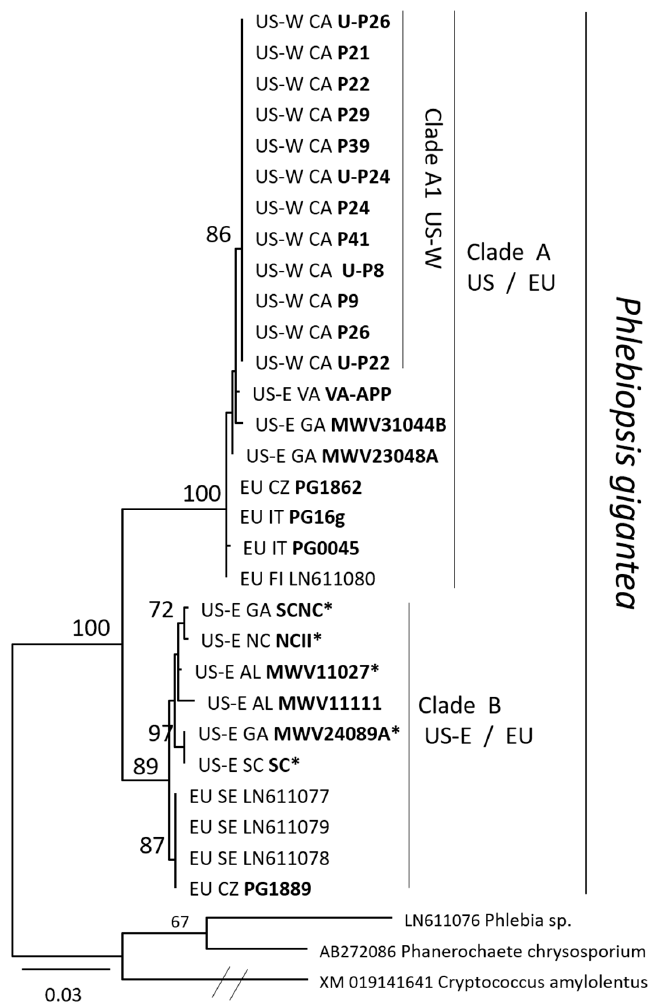
Figure 8. Maximum likelihood phylogram obtained from the GPD sequence alignment of Phlebiopsis gigantea . Phlebia sp. (LN611076), Phanerochaete chrysosporium (AB272086) and Cryptococcus amylolentus (XM019141641) were used as outgroup taxa. ML bootstrap percentages ≥ 70% are given above each clade. Labels indicate: geographic area, state, isolate code (in bold for sequences newly generated) and GenBank code brackets for sequences retrieved from NCBI. * presence of deletion (-TATGCCT-) in the V intron.